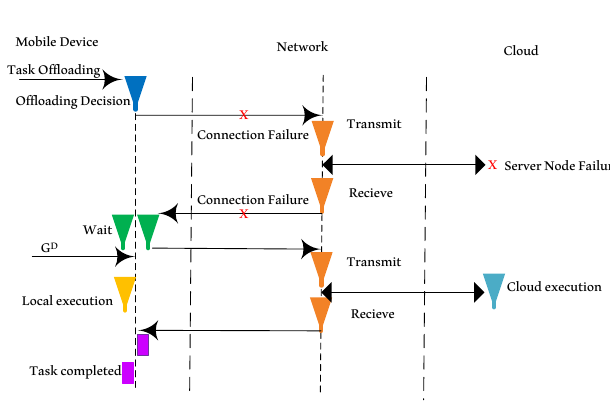
Figure 4. Failure Recovery